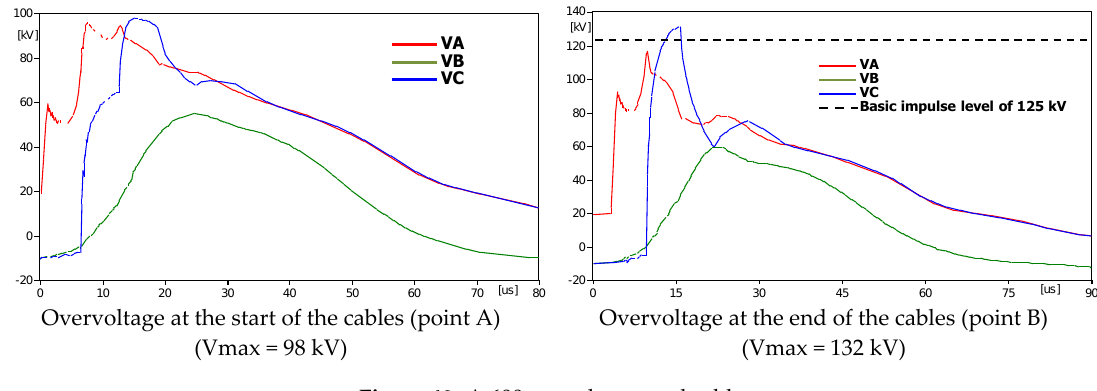
Figure 40. A 600 m underground cable.